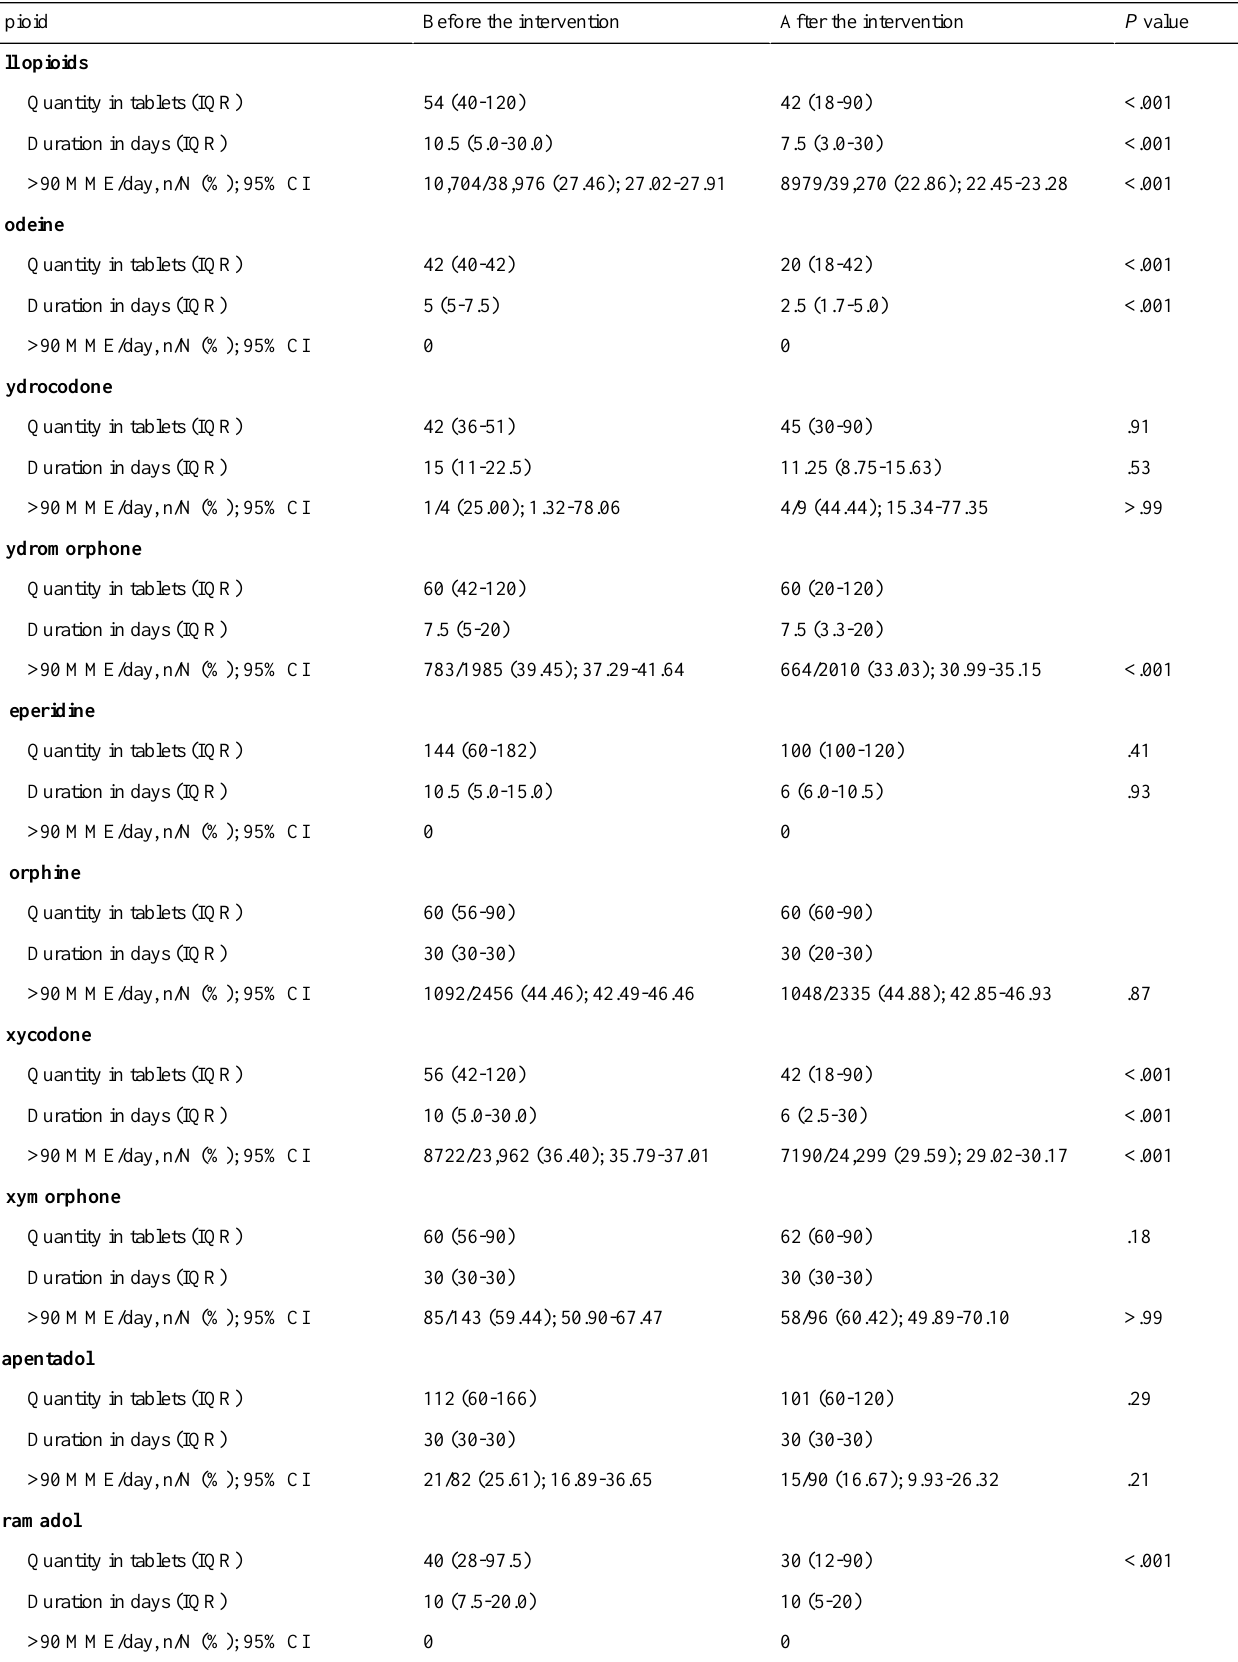
P valueAfter the interventionBefore the interventionOpioid